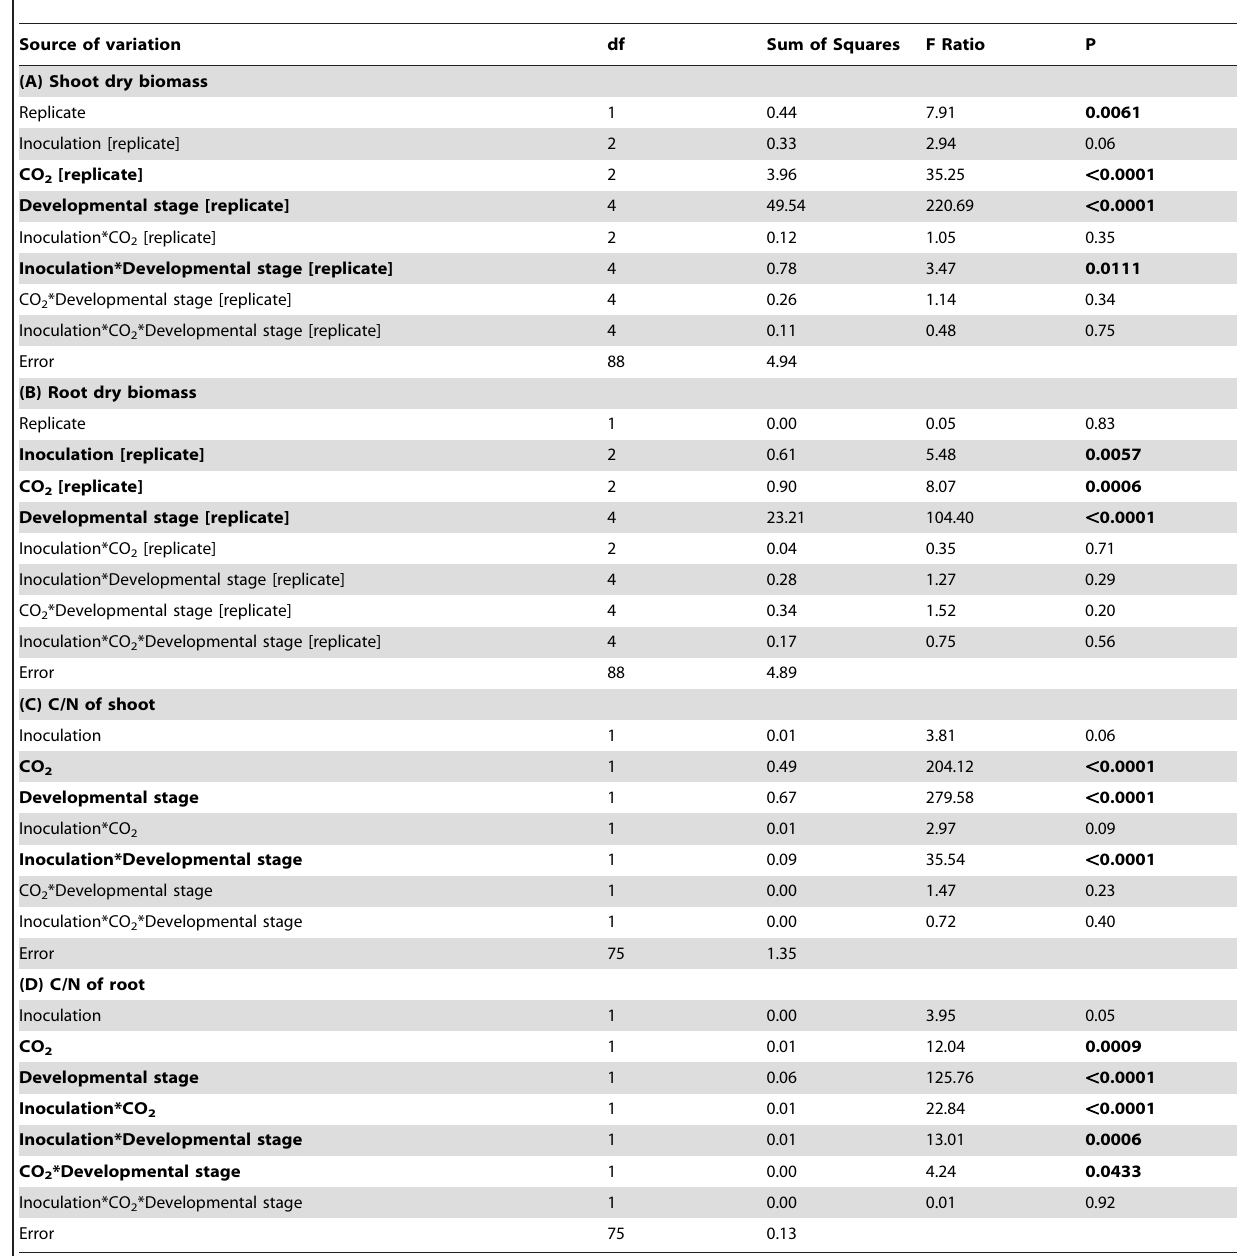
Table 2. Linear models explaining the vegetative traits of Medicago truncatula as a function of inoculation conditions (inoculated or not with Pseudomonas fluorescens C7R12), CO 2 concentration (ambient, 365 ppm or enriched, 750 ppm), the plant developmental stage (V, Fp and Pf, see text) and the experimental replicate (nested factor), excepting for the C/N ratios (C,D) which were measured in the second experiment only for the Fp and Pf